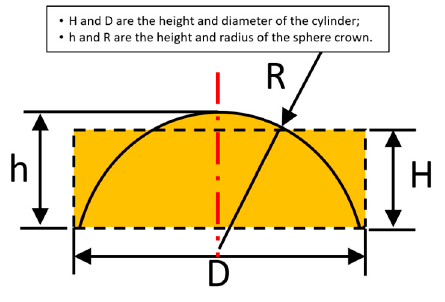
Figure 2. Structures of photoresist before and after